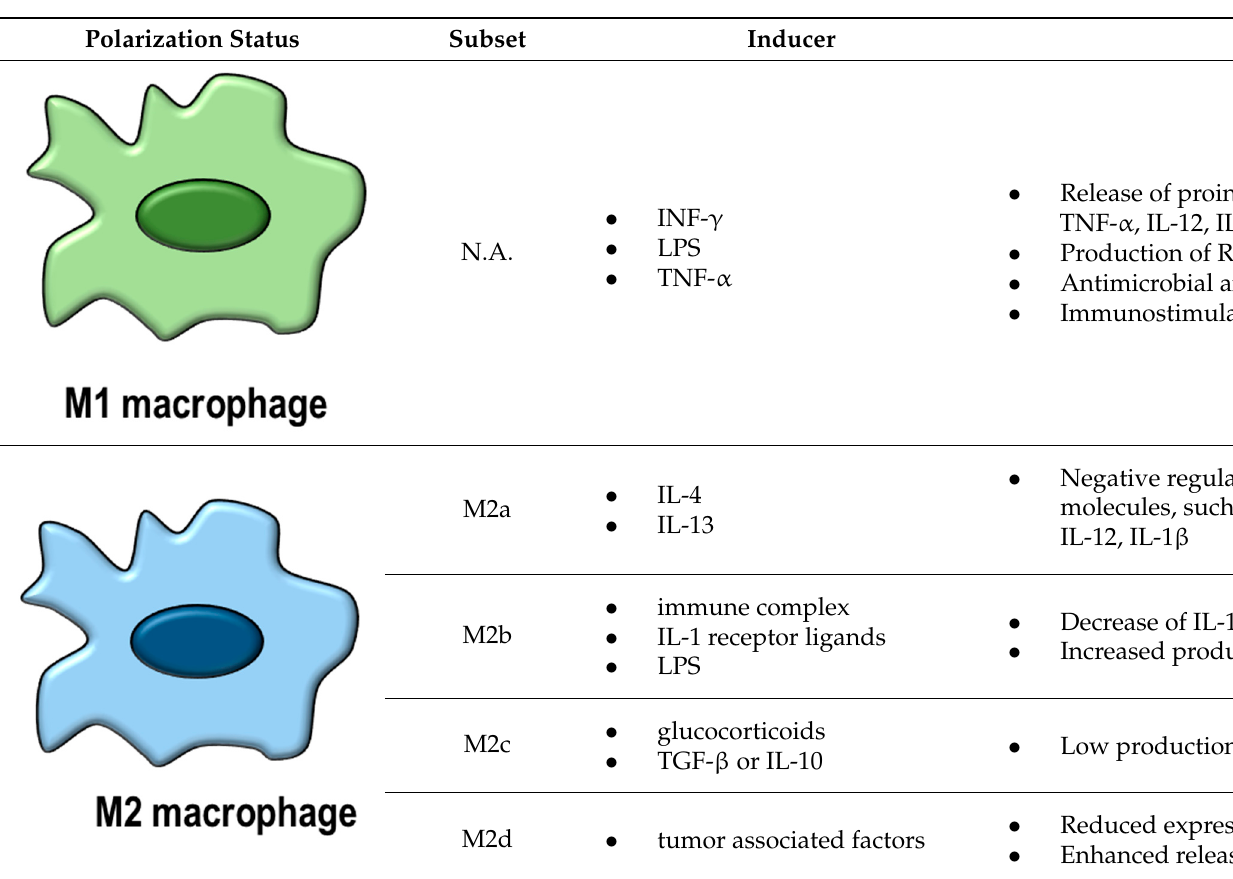
Table 1. Schematic representation of the macrophage phenotypes and their characteristics (N.A.= not applicable).